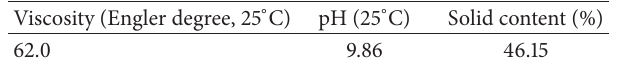
Table 5: SBR latex